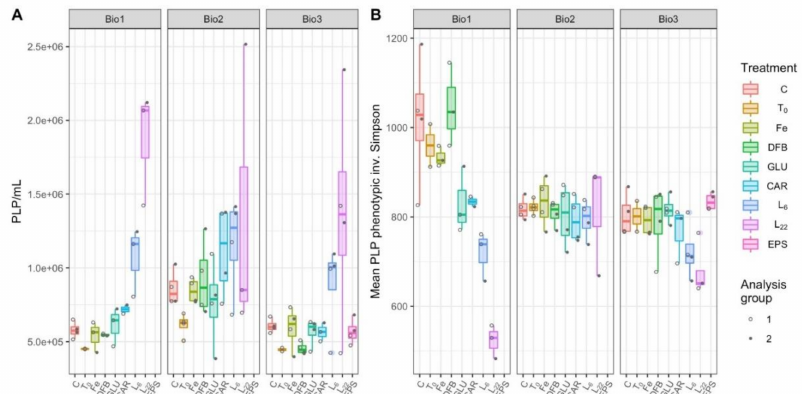
Figure 5. Prokaryote–like particles (PLP) concentrations ( A ) and phenotype-based inverse Simpson alpha diversity ( B ) of microbial communities during incubations with di ff erent treatments performed at each station (Bio 1–3). The treatments presented are: Ctrl (control, no Fe enrichment), Fe (inorganic Fe addition, FeCl 3 ), DFB (desferrioxamine B), GLU (glucuronic acid), CAR (carrageenan), L 6 [bacterial exopolymeric substance (EPS)], and L 22 (bacterial EPS). Each point in panel B represents the mean of 100 bootstrapped iterations of FCM events randomly downsampled to the lowest count of gated events across the